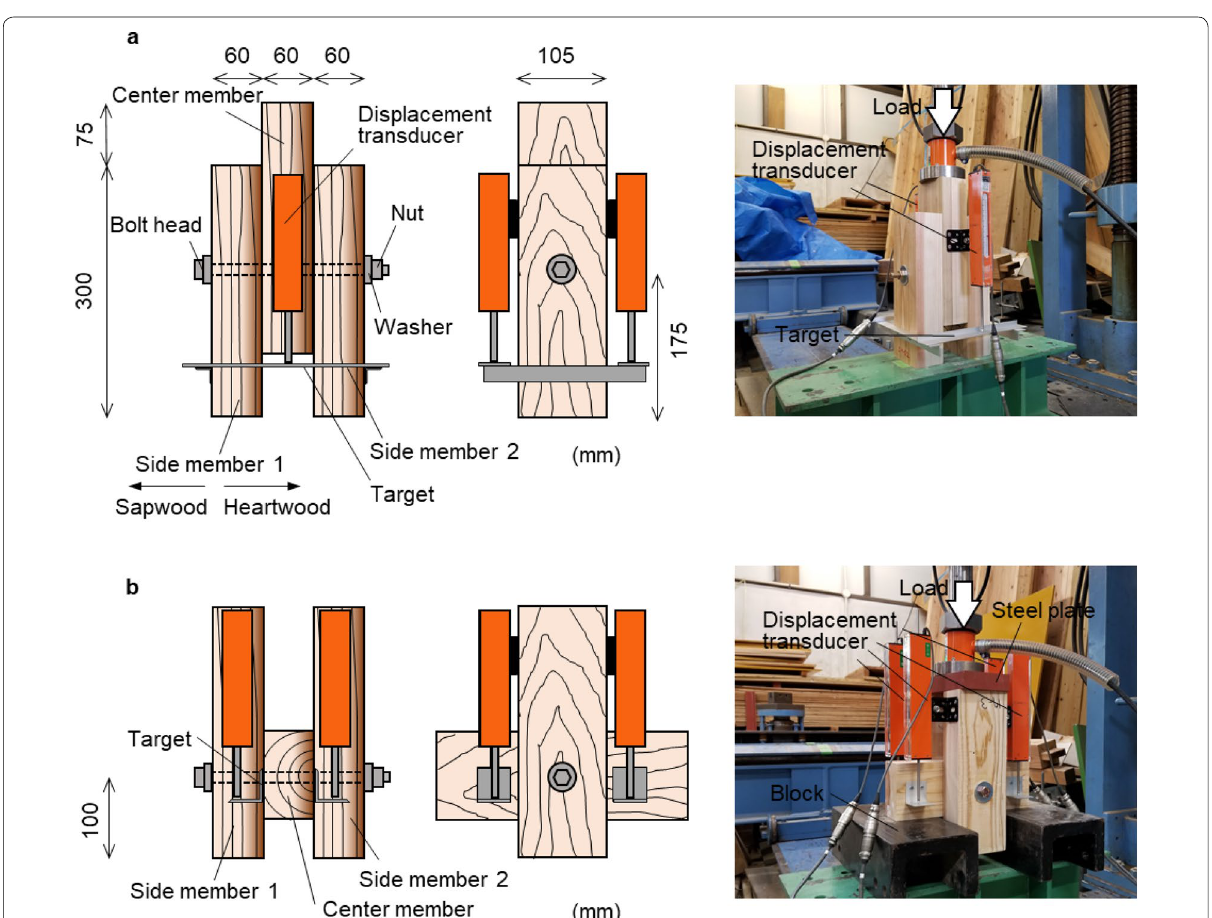
Fig. 4 Joint specimens and experimental setups. a Groups loaded parallel to the grain. b Groups loaded perpendicular to the